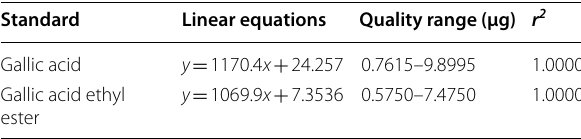
Table 1 Linear analysis parameters of gallic acid and gallic acid ethyl ester Standard Linear equations